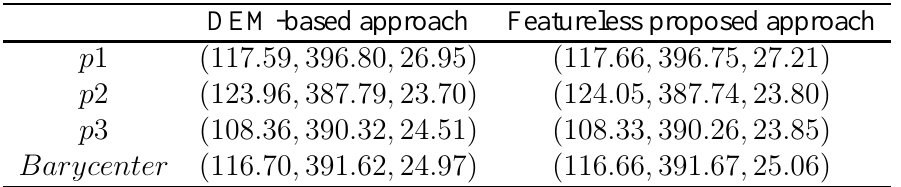
Table 2. Comparison of 3D modeling results obtained in the first case from a DEM-based approach and in the second case from our direct image-based approach.